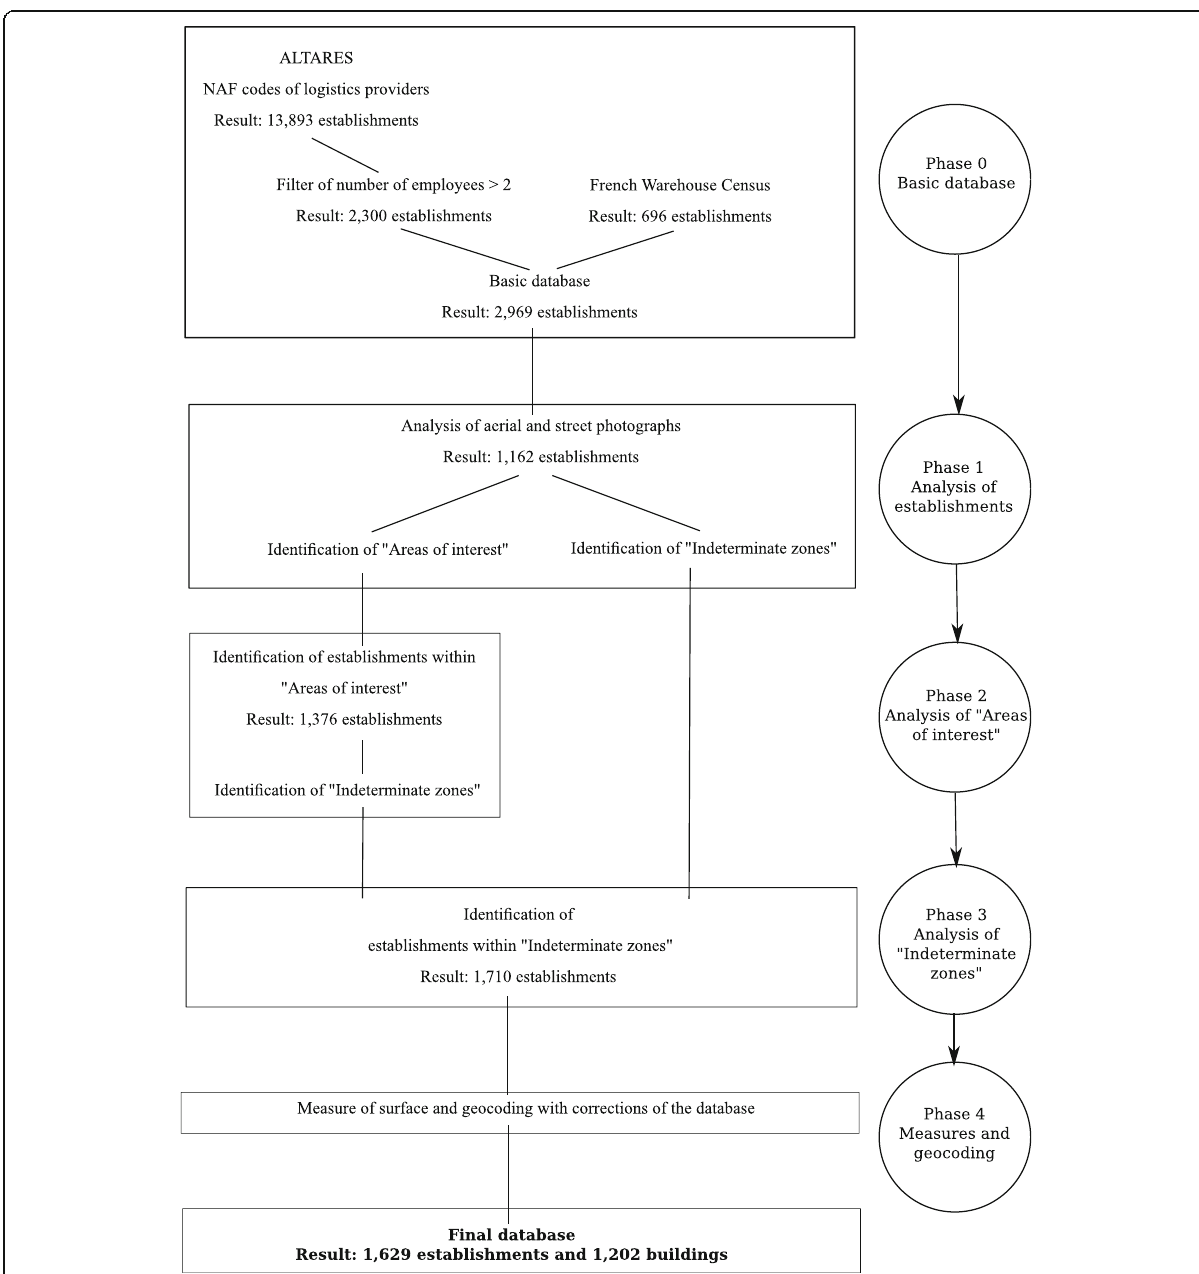
Fig. 1 Description of the methodology for building a comprehensive census of logistics facilities (source: